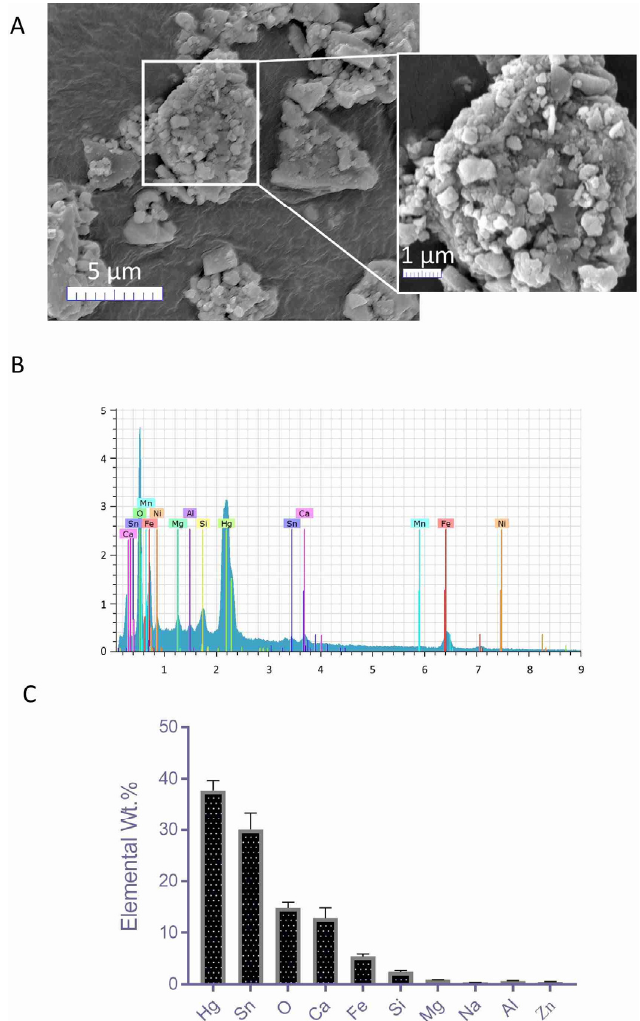
Figure 2. Scanning electron microscope (SEM) and electron dispersive X-ray (EDX) analysis of Yogendra Ras (YDR). ( A ) SEM analysis of the YDR powder showed the presence of a heterogeneous mass of particles of varying shapes and sizes. Particles were present individually or as aggregates. ( B ) Electron dispersive X-ray analysis showed the presence of various elements on the surface of the YDR particles. ( C ) Quantitatively highest elemental concentrations were detected for mercury (Hg), tin (Sn), oxygen (O), calcium (Ca) and iron (Fe). Several other elements such as silicon (Si), magnesium (Mg), sodium (Na), aluminum (Al), and zinc (Zn) were also detected but at ≤ 1% w / w concentrations. Inductively coupled plasma mass spectroscopy (ICP-MS) analysis of YDR samples showed the presence of 9.8% mercury (Hg) and 7.9% gold (Au). X-ray di ff raction (XRD) crystallography analysis of the YDR sample confirmed the presence of Hg in the form of Cinnabar and Metacinnabar (HgS) (Figure 3A). Using the XRD analysis, the presence of pure gold (Au), hematite (Fe 2 O 3 ), arsenic trioxide (As 4 O 6 ), and AsFe were identified in the YDR samples (Figure 3A). Several other crystal peaks were also detected in low amounts in the XRD analysis. Dynamic light scattering (DLS) analysis of the YDR particles showed a size distribution transformation when the suspension medium was changed from water to complete cell culture media. In pure water suspension, YDR showed a bimodal size distribution with an average dynamic size distribution of 1116.00 ± 102.70 d.nm (Figure 3B). However, when suspended in the DMEM media supplemented with 2% FBS, YDR size distribution changed to a monomodal distribution showing a size of 486.40 ± 46.95